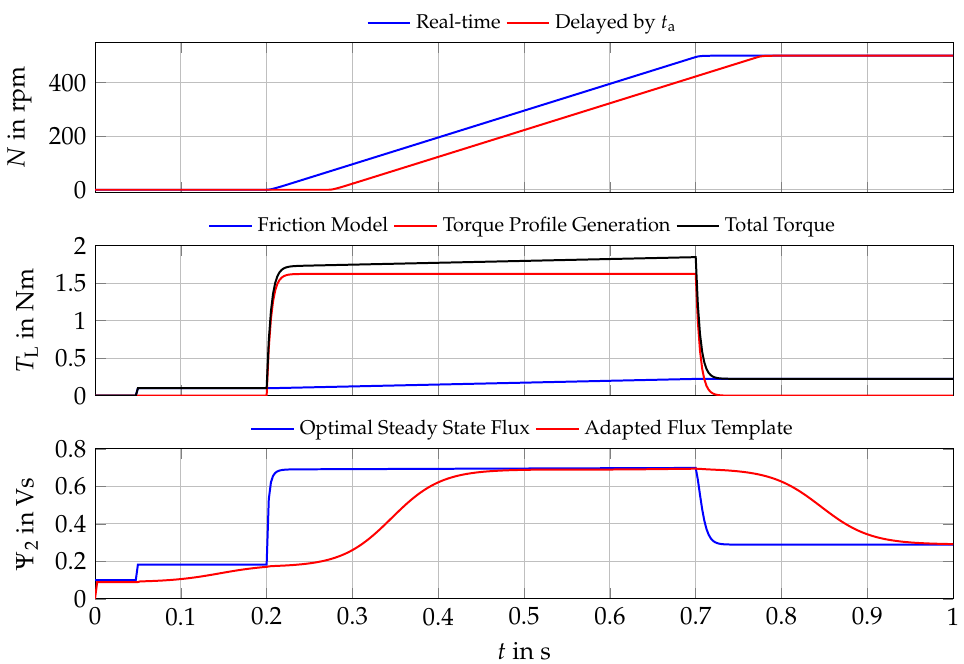
Figure 9. Trajectories generated by the template adaptation